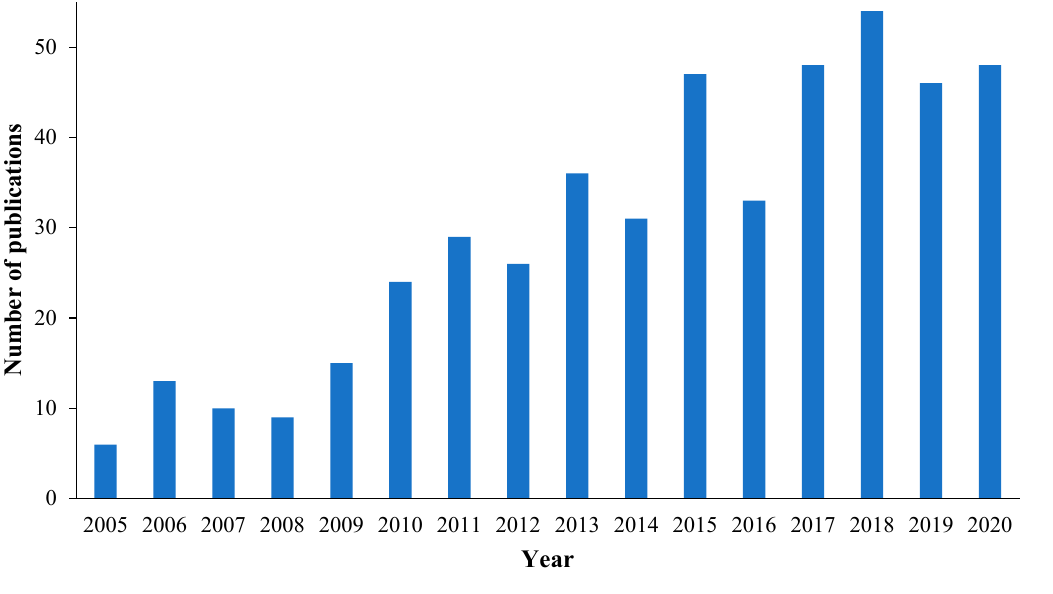
Figure 2. Annual Number of publications from 2005 to 2020 retrieved via the keyword “nanocom- posite” and “pervaporation” in the topic of the paper, as reported by Web of Science (http://apps.webofknowledge.com, 15 June 2021).